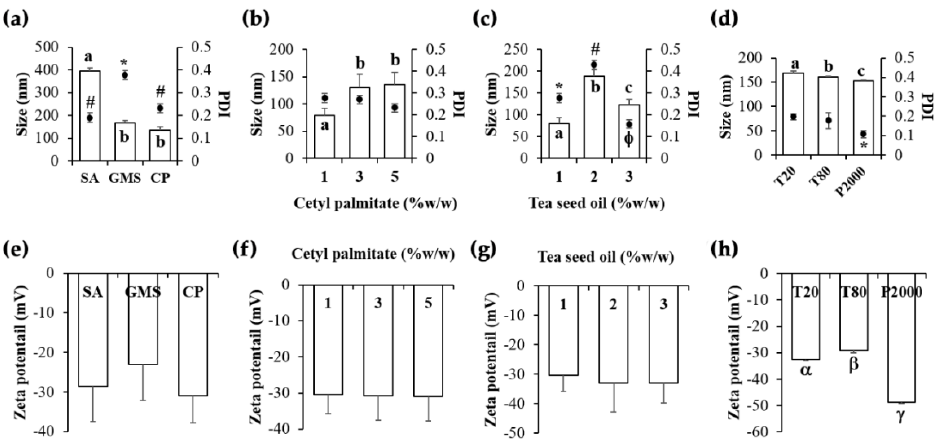
Figure 2. Particle size and polydispersity index (PDI) of nanostructured lipid carriers were developed using ( a ) different types of solid lipid at the same concentration of 5% w/w , ( b ) various amounts of cetyl palmitate, ( c ) various amounts of tea seed oil, and ( d ) different types of surfactants at the same concentration of 2.5% w/w . Zeta potential of nanostructured lipid carriers were developed using ( e ) different types of solid lipid, ( f ) various amounts of cetyl palmitate, ( g ) various amounts of tea seed oil, and ( h ) different types of surfactants. Different types of solid lipids included stearic acid (SA), glyceryl monostearate (GMS), and cetyl palmitate (CP). Different types of surfactants included Tween 20 ® (T20), Tween 80 ® (T80), and Plantacare 2000 ® (P2000). The letters, a, b, and c denote values that were significantly di ff erent in particle size ( p < 0.05), whereas, the symbols, * , #, and ϕ denote values that were significantly di ff erent in PDI ( p < 0.05). The symbols, α , β , and γ denote values that were significantly different in zeta potential ( p < 0.05).